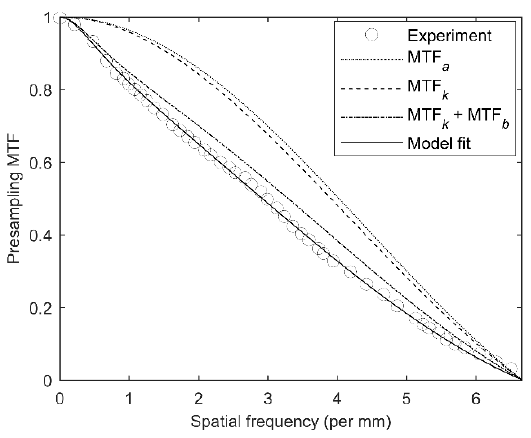
Figure 2. MTF( f ) for a negatively biased a -Se detector of 1 mm thickness at 75 kVp X-ray exposure with 39.7 mm Al filtration. The applied electric field F = 10 V/µm and the average photon energy is 59 keV. The bottom blocking layer thickness, d b = 15 µm and pixel size, a ′ = 150